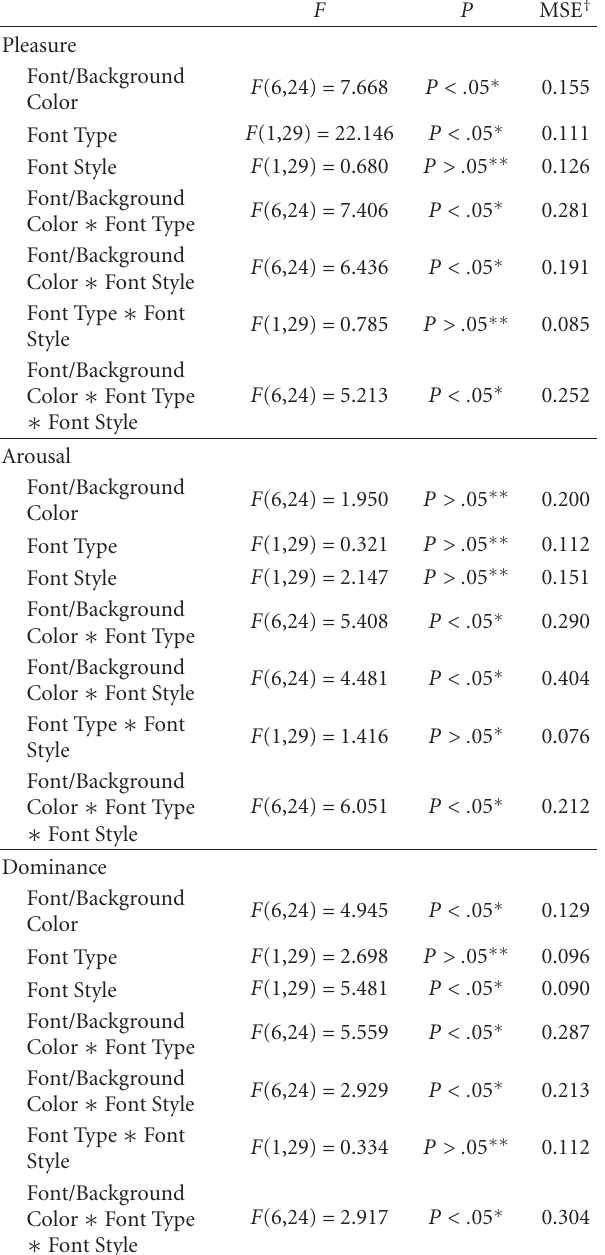
Table 2: Three-way repeated measures ANOVA results for each dependent emotional dimension (PAD) on font/background color combinations, font type, font style, and their interactions.